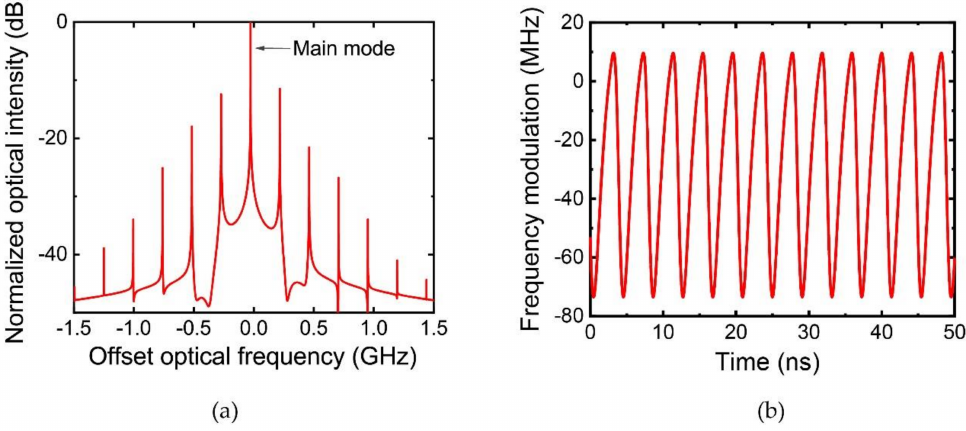
Figure 6. ( a ) Simulated optical spectrum and ( b ) frequency modulation of the QCL with P1 oscillation. The single-trip feedback length is 60 cm, and the LBF is